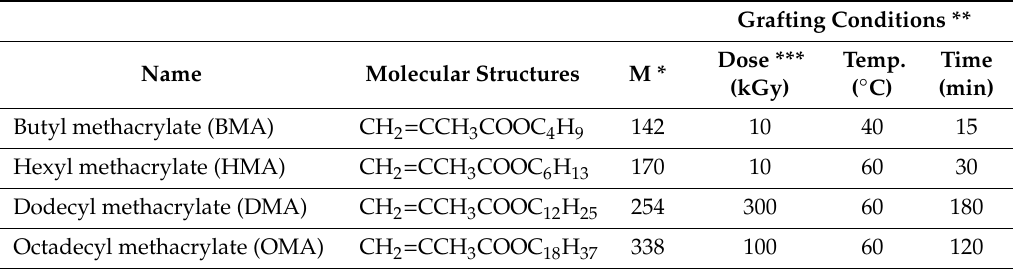
Table 1. Methacrylate monomers and grafting conditions used in this